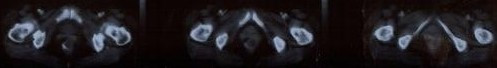
A pelvic CT showed a tumor 2 cm in size at the lower anterior mesorectum.